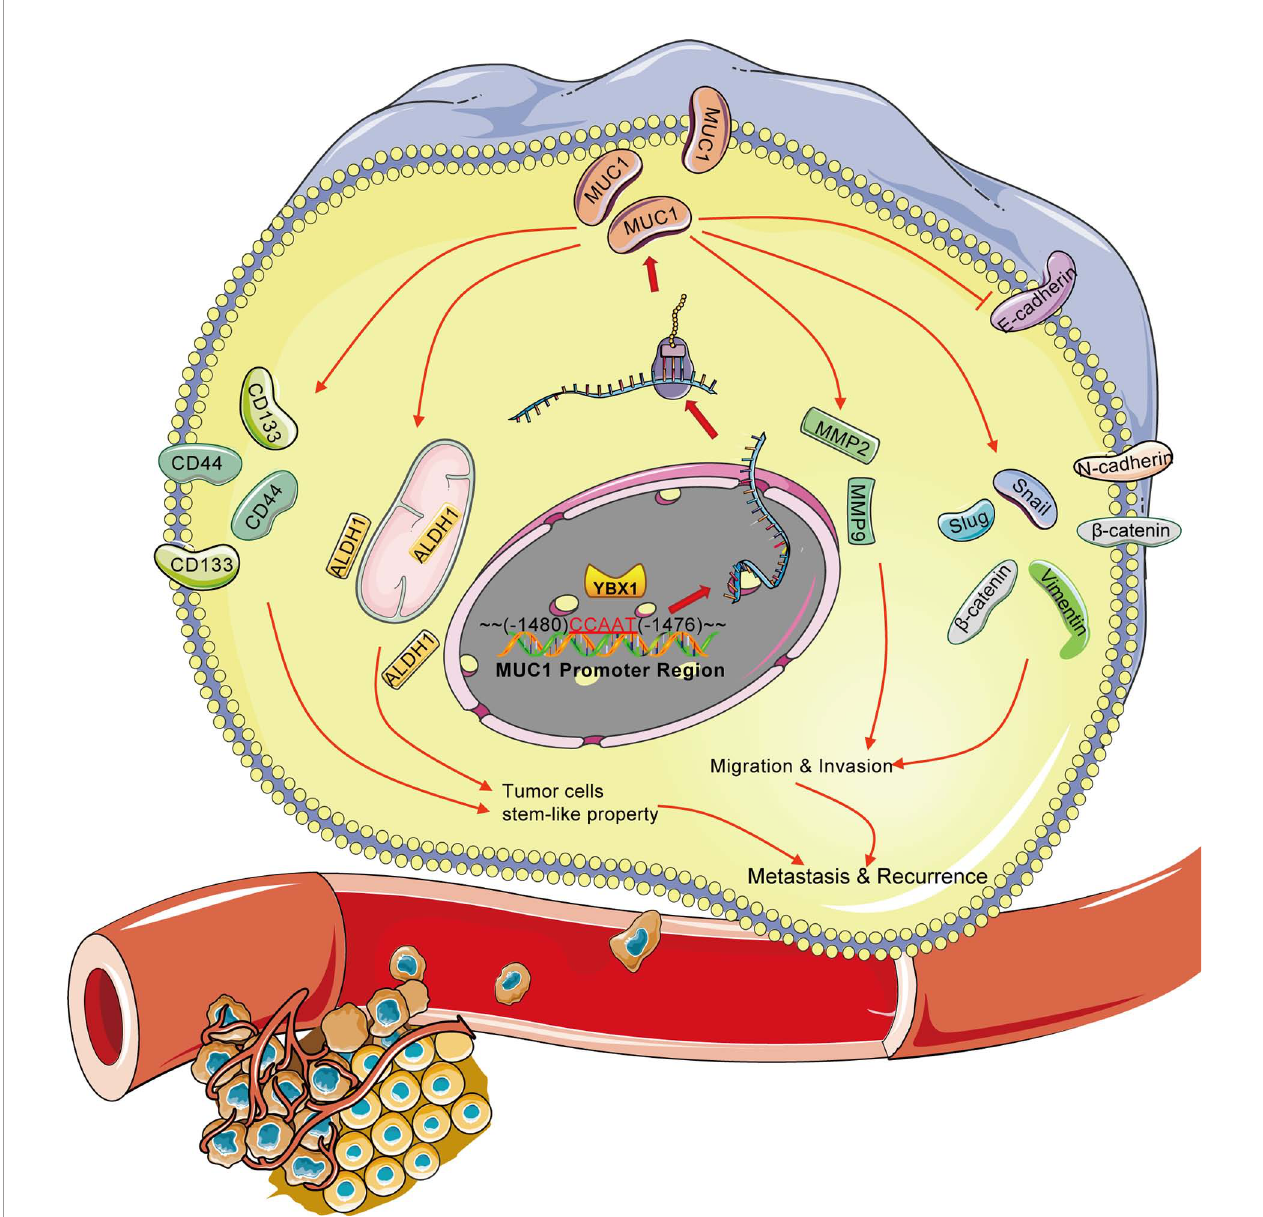
FIGURE 7 | Overview of the transcriptional regulation between YBX1 and MUC1 in lung adenocarcinoma. Activation of MUC1 promoter regions (from -1480 to -1476) by YBX1 promotes the stemness and metastasis of lung adenocarcinoma. The arrow ( ! ) indicates direct or indirect positive regulation. The symbol ( ┤ ) indicates negative